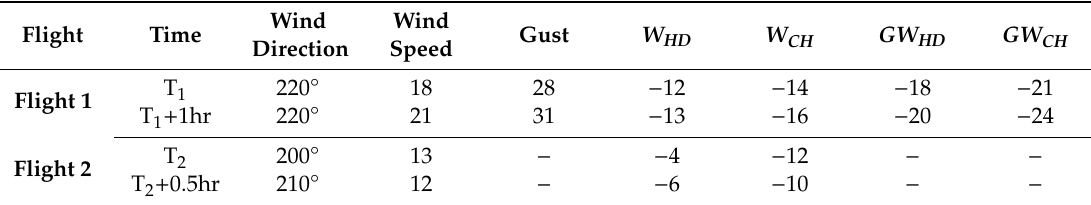
Table 1. Wind data (velocity in knots) based on METAR (Meteorological Aerodrome Reports) at Pico aerodrome at the time of flights. The crosswind ( W CH ) is from the left if negative. Negative values of W HD indicate headwinds. T 1 and T 2 are approximate landing times for Flights 1 and 2.